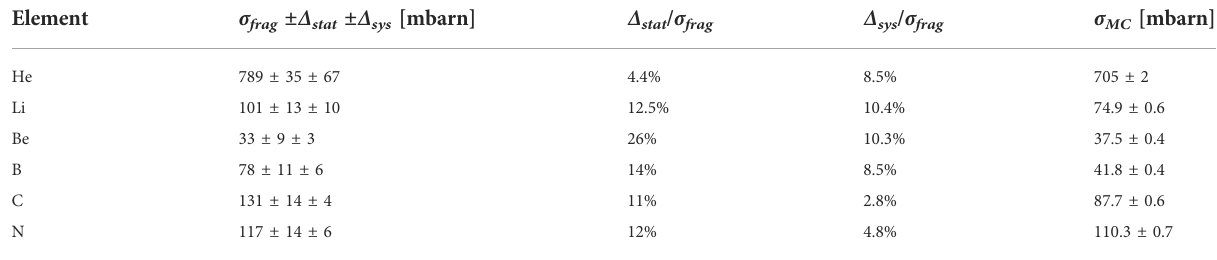
TABLE 4 Elemental fragmentation cross sections measured in this work, for a 400 MeV/u 16 O beam interacting with a 5 mm graphite target. The energy of the 16 O beam at target center is 393 MeV/u. The results are compared with FLUKA MC predictions (last column).